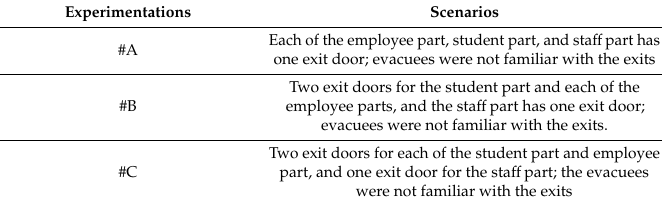
Scenarios ff parthas #A Eachoftheemployeepart,studentpart,andsta one exit door; evacuees were not familiar with the